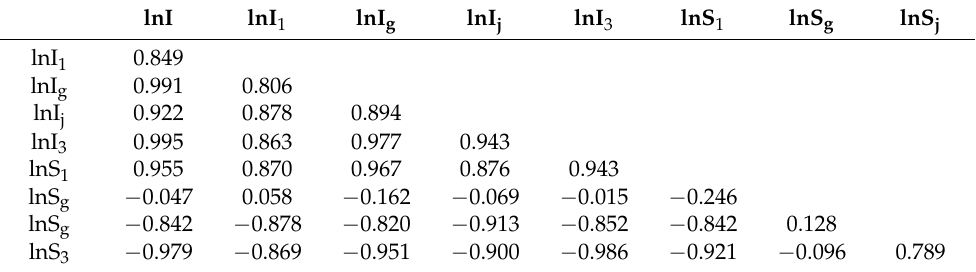
Table 1. Correlation coefficients of energy intensity and influencing factors.